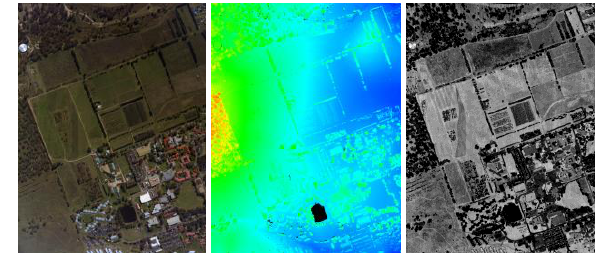
Figure 7. Aerial image (left), colour-coded LiDAR DSM (middle) and LiDAR intensity image (right).